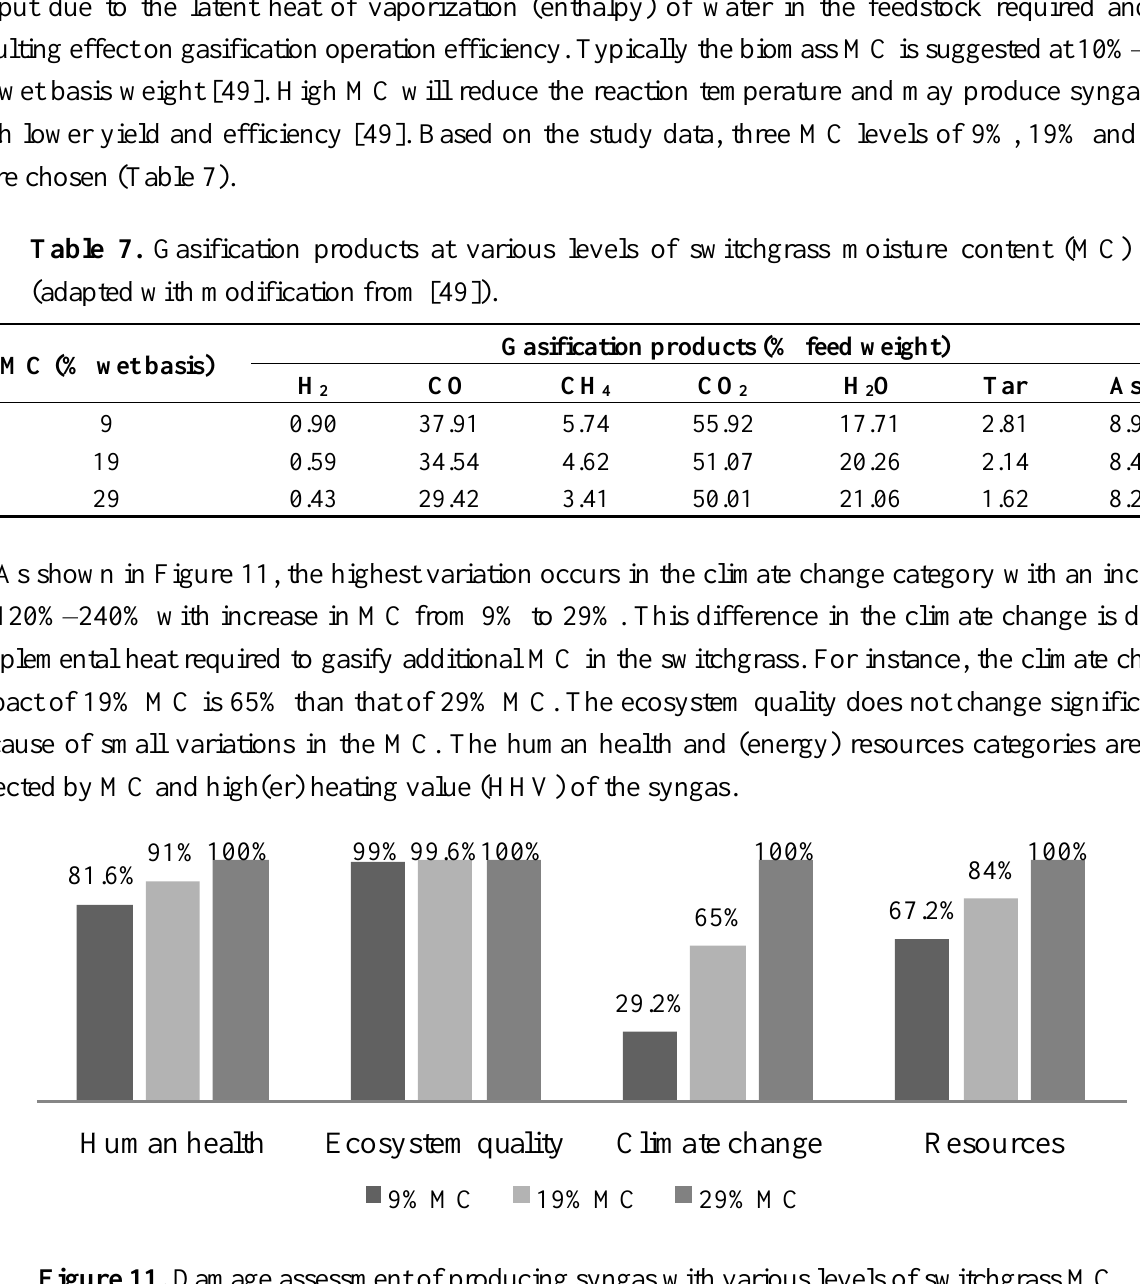
Figure 11. Damage assessment of producing syngas with various levels of switchgrass